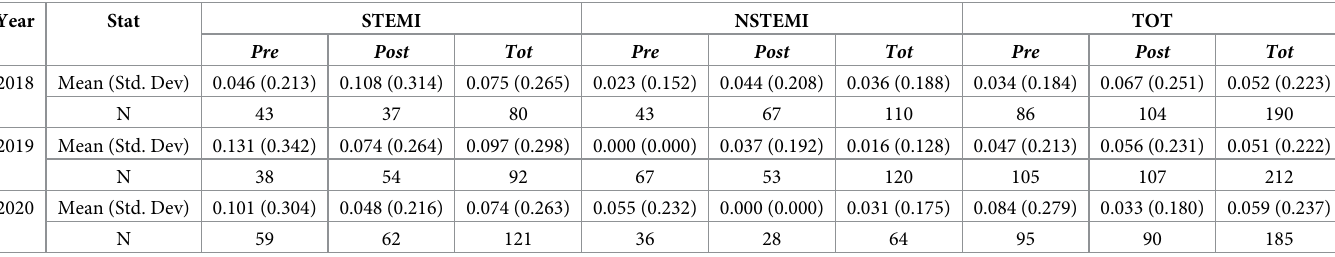
Table 1. Mortality rates of AMI by type (STEMI and NSTEMI) (January 1- May 31, by